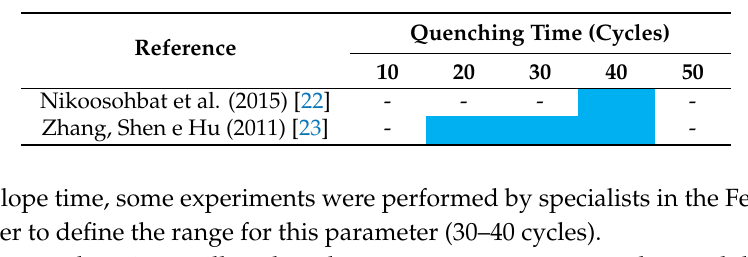
Table 3. Ranges for the quenching time used in previous